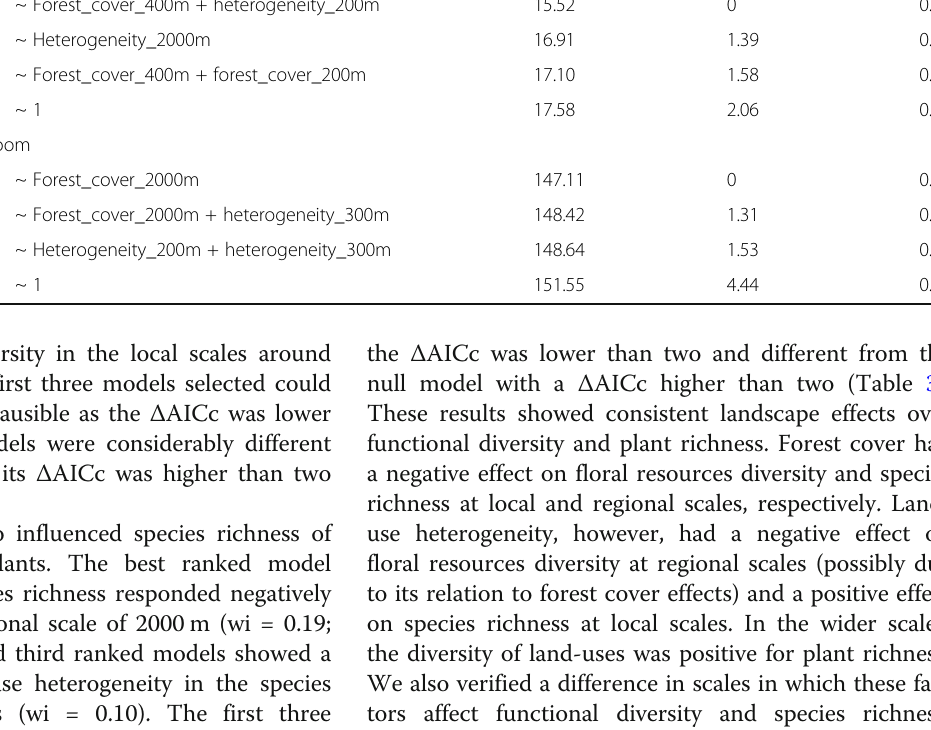
Species richness of plants in bloom